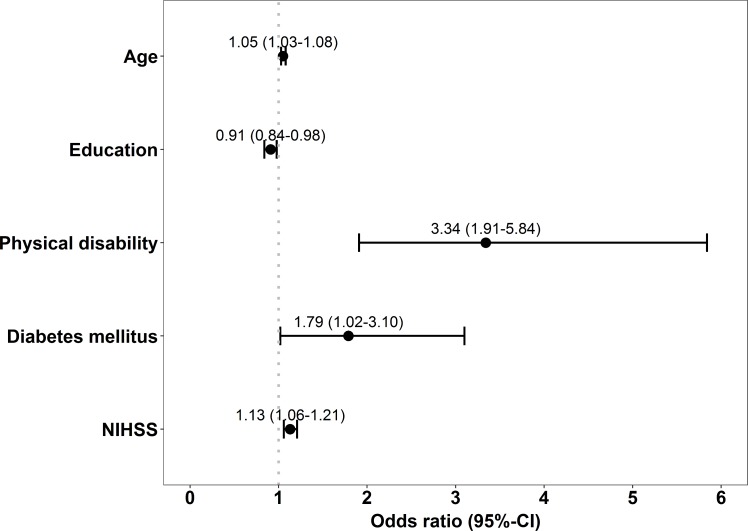
Odds ratios and respective confidence intervals gained by multiple binary logistic regression analysis after backward selection.